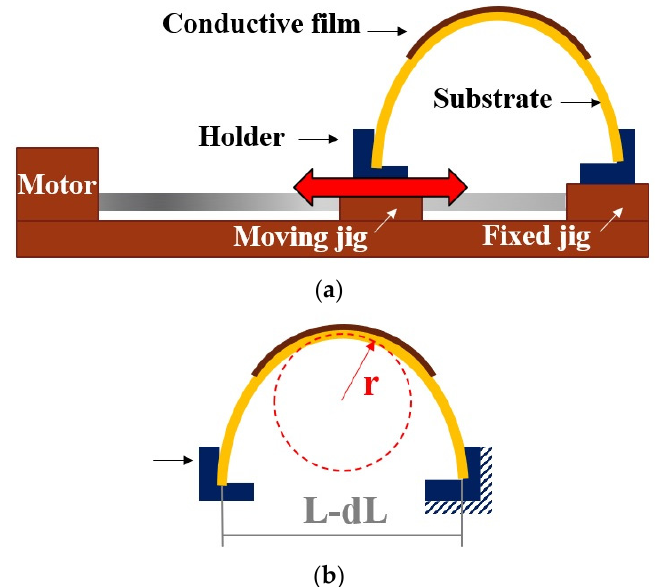
Figure 2. Bending experiment schematics: ( a ) bending apparatus ( b ) bending radius.